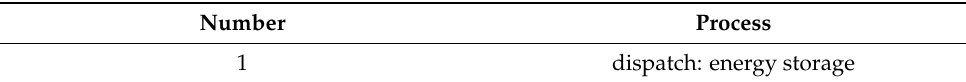
Table A2. Activities of the main application process “repurpose”: dispatch.